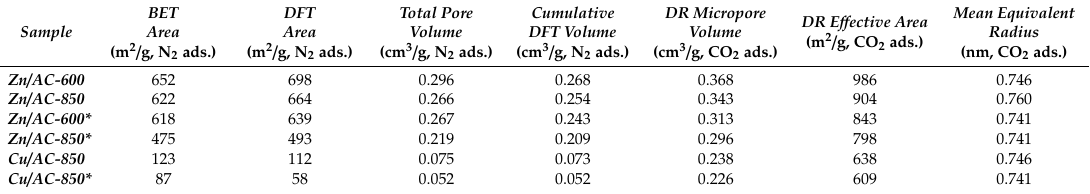
Table 3. Textural properties of activated carbons evaluated according to BET, DFT and DR models. BET Sample Area (m 2 / g, N 2